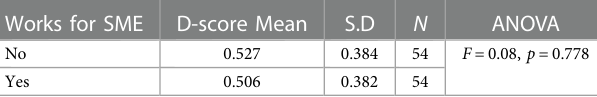
TABLE 3 Effect of company size on disability IAT scores ( N =108).